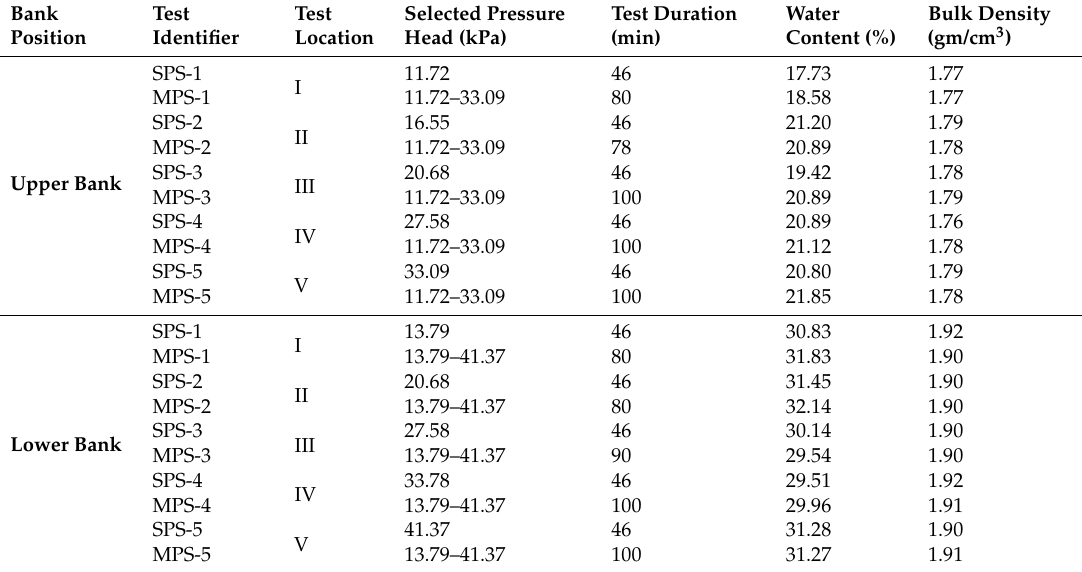
Table 2. Mini-jet test conditions comparing single pressure setting (SPS) and multiple pressure settings (MPS) field data procedures at the Gist Creek study site, including soil properties among the five test locations per upper and lower bank